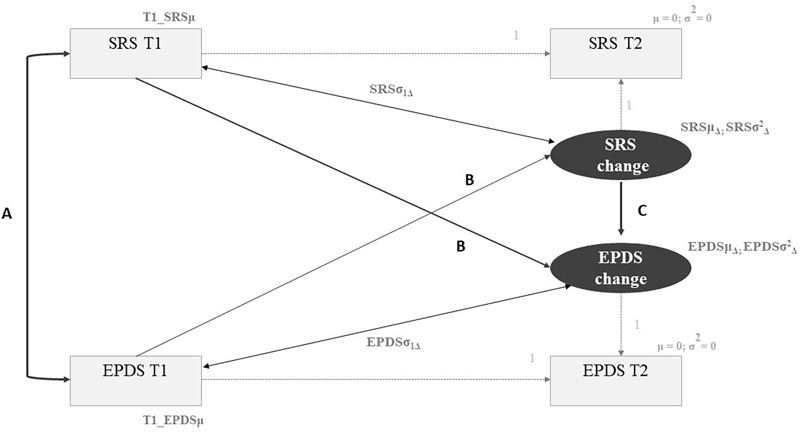
Two-wave Latent Change Score Model. Light gray parameters correspond to the estimations of the univariate Latent Change Score model. SRS, self-regulatory skill (emotion regulation abilities, psychological flexibility, self-compassion). EDPS, depressive symptoms. T1, baseline assessment. T2, post-intervention assessment. Parameter A, Correlation between individual’s scores at T1. Parameter B, Cross-lagged paths between T1 scores in one variable and the change score in the other variable. Parameter C, Change-to-change effect (effect of the change in one variable on the change of the other variable).